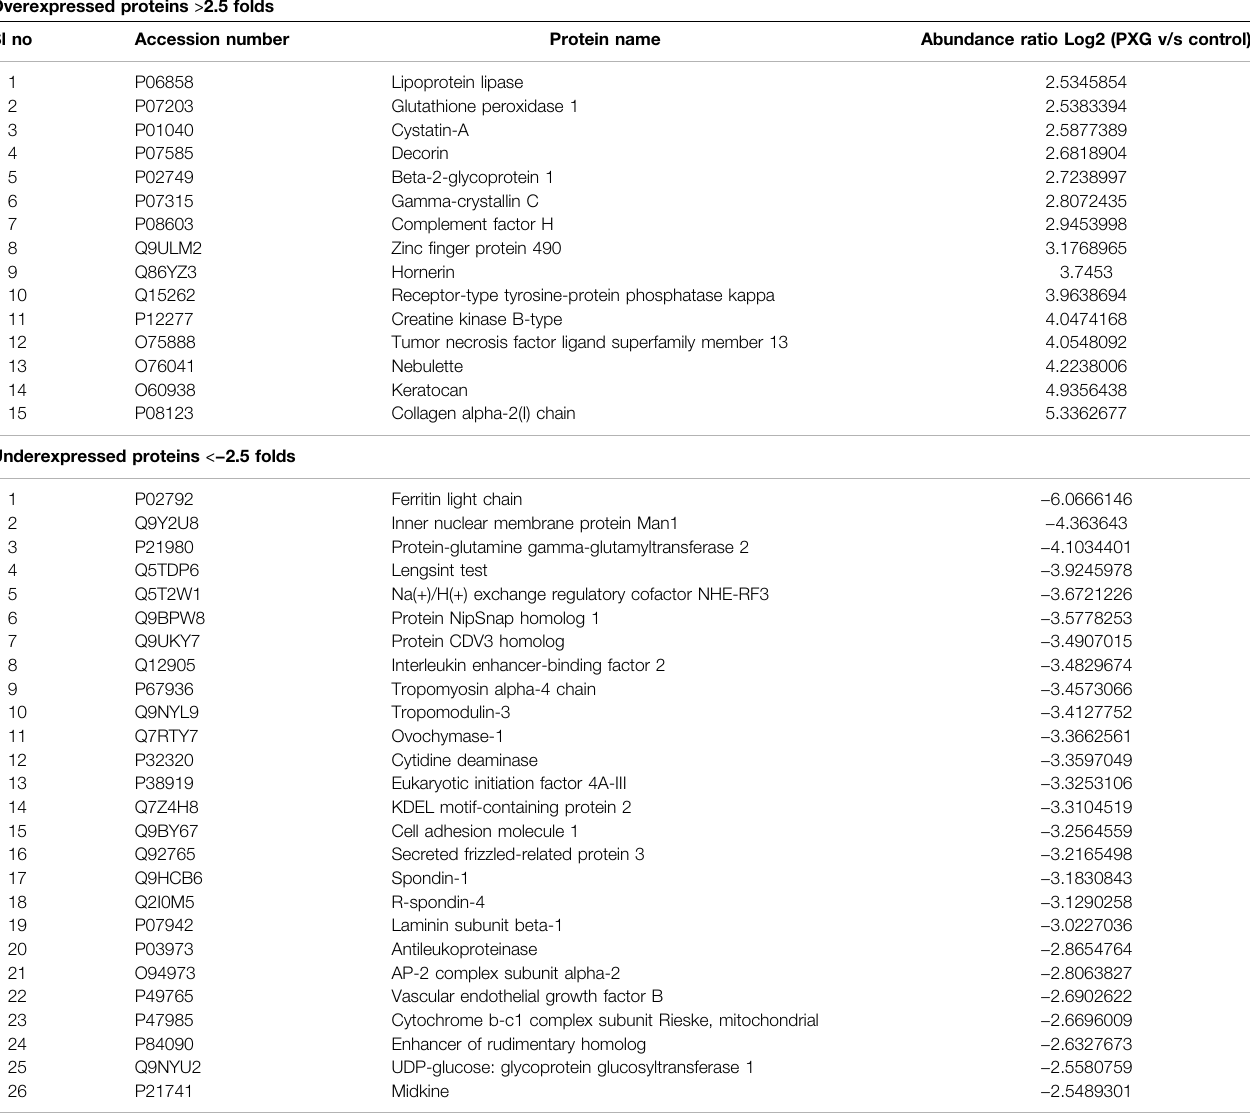
TABLE 4 | Top overexpressed and underexpressed proteins in the lens capsules with pseudoexfoliation glaucoma (PXG) compared to the control. Overexpressed proteins > 2.5